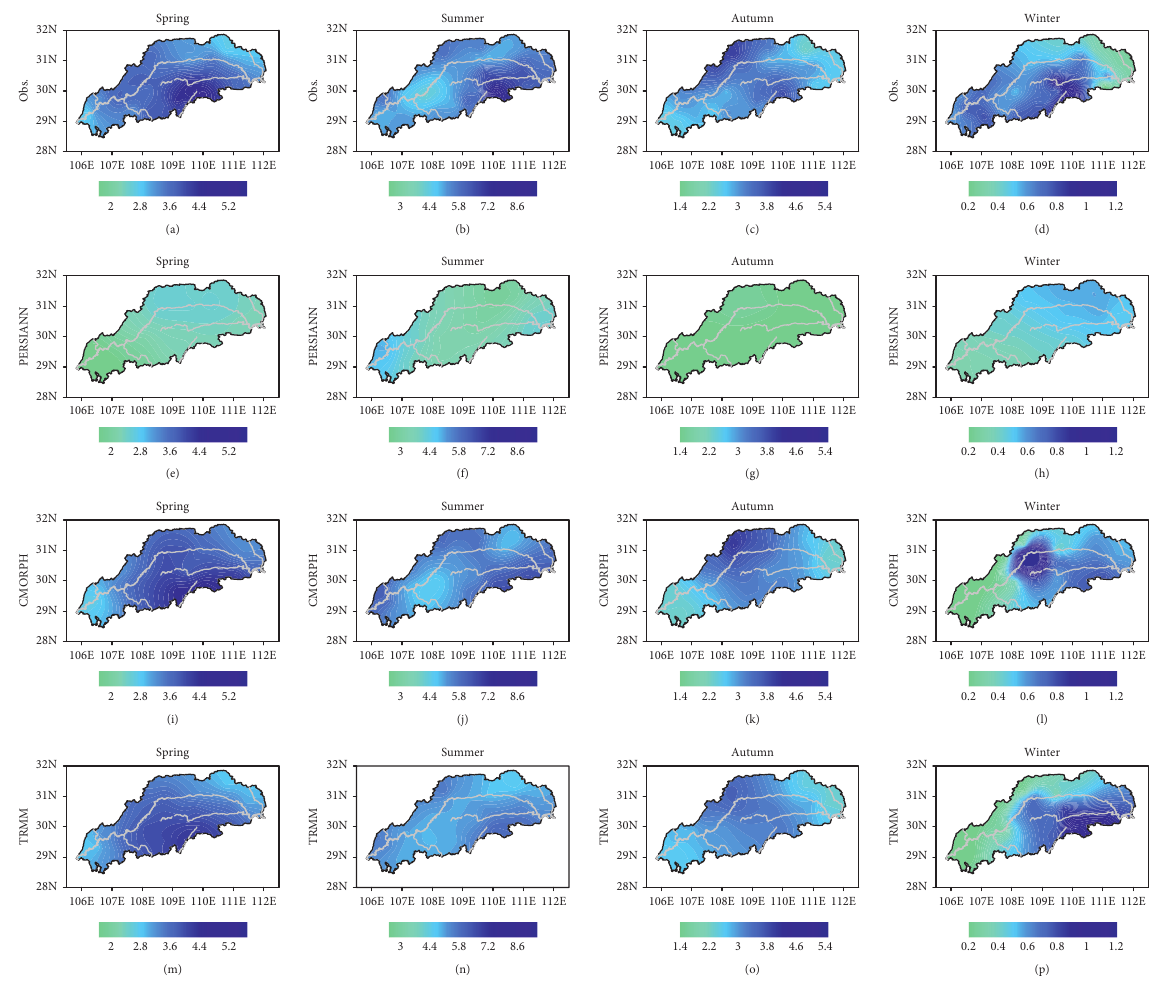
Figure 14: The spatial distribution of seasonal mean precipitation (units: mm/day) for each Laifeng stations and about 2 days around Qijiang and stations. Conversely, the PERSIANN underestimated the Wulong stations (Figure 22(d)). The above results sug- extreme precipitation by about 150 mm over the entire gested that each satellite product had its own bias in reservoir area. estimating the extreme precipitation, and the CMORPH was comparatively the best of all. The maximum precipitation during the daytime, nighttime, and the whole day was given in Table 5. Among all satellite products, the CMORPH was closest to the observation in the daytime (bias around 2 mm). The PERSIANN estimates were the best of all during the nighttime (bias around 2 mm) and the whole day (bias around 4 mm). Both TRMM and CMORPH overestimated stations. the the maximum rainfall for all three periods, but instead, the PERSIANN underestimated the maximum rainfall. It by about 1 day and also in the downstream area by 1-2 could be inferred from the rainfall data (Table 1) that the days (Figure 22(c)). The CMORPH overestimation in the daily biases of TRMM and PERSIANN were mostly at- downstream area covered Zigui, Yichang, Changyang, and tributed to the estimate errors in daytime whereas the Badong stations. In contrast, the PERSIANN under- daily bias of CMORPH was basically related to the esti- estimated the CWD over the southern reservoir area by mate errors in the nighttime. about 1 day around Nanchuan, Pengshui, Qianjiang, and